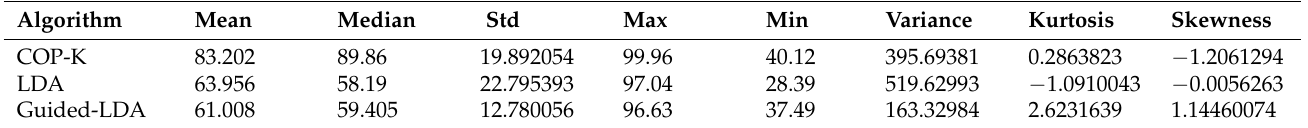
Table 4. Semi-supervised algorithm